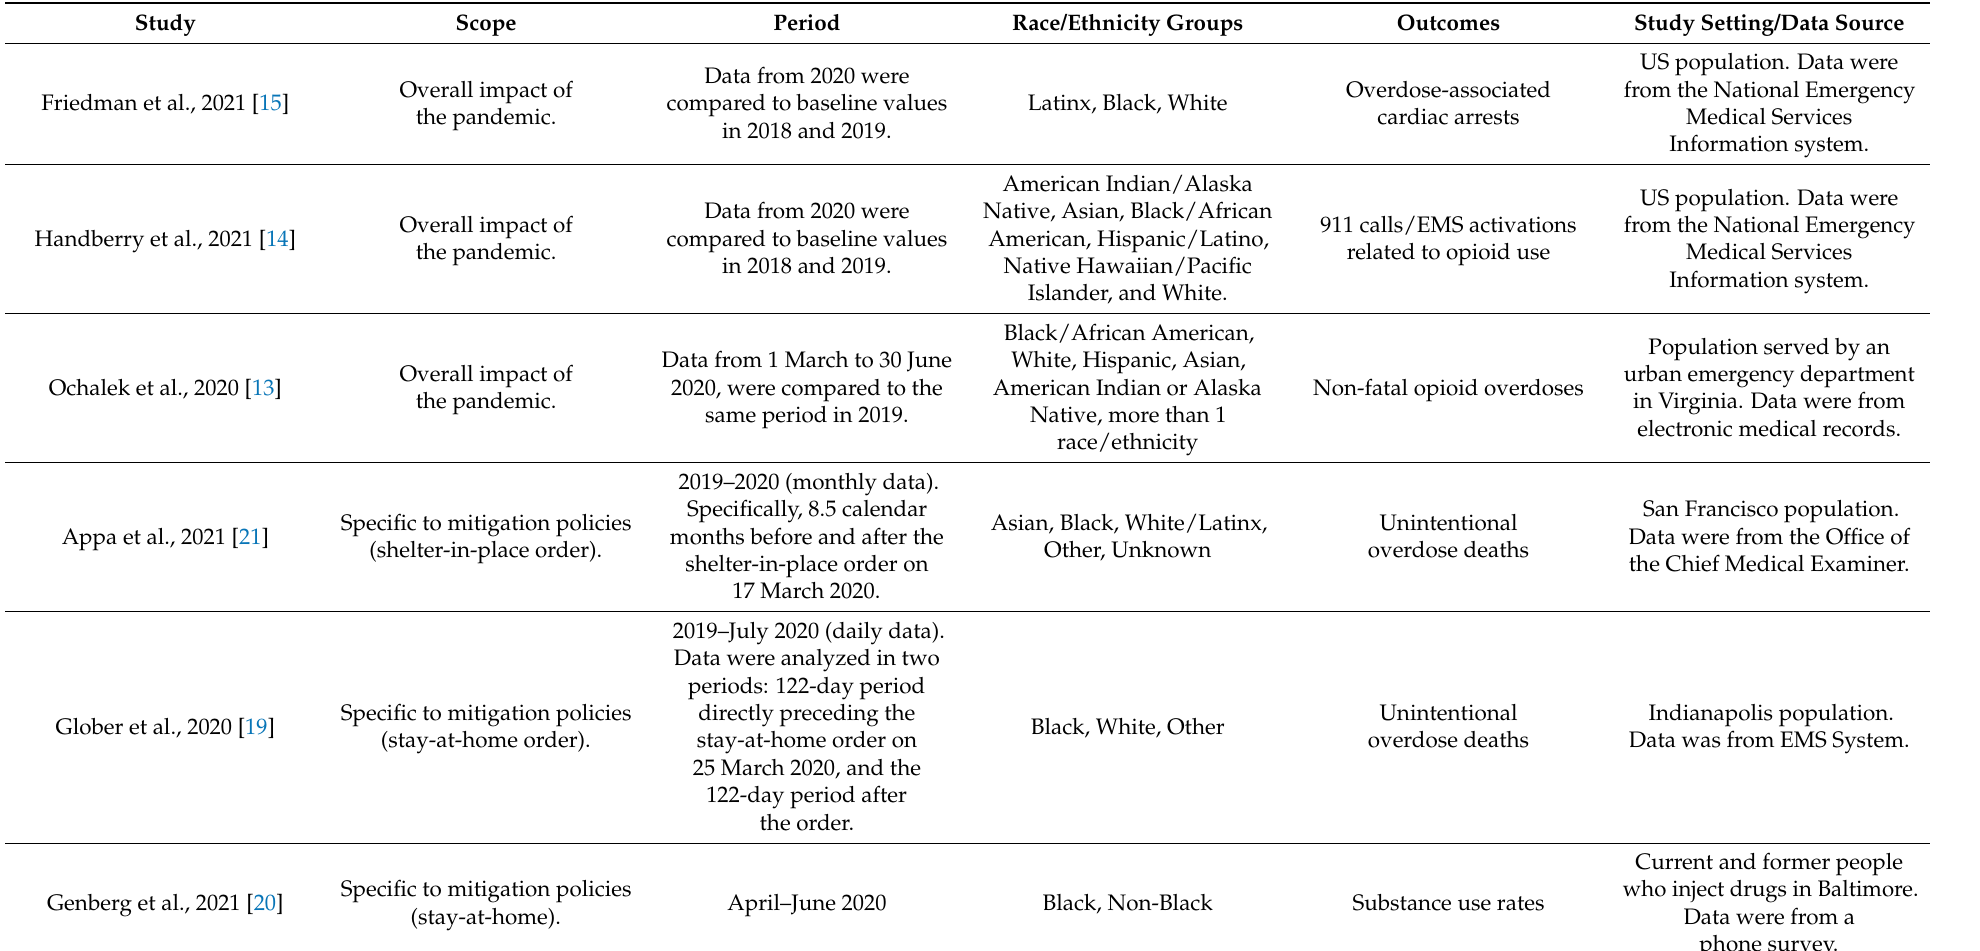
Table 1. Overall characteristics and scope of the